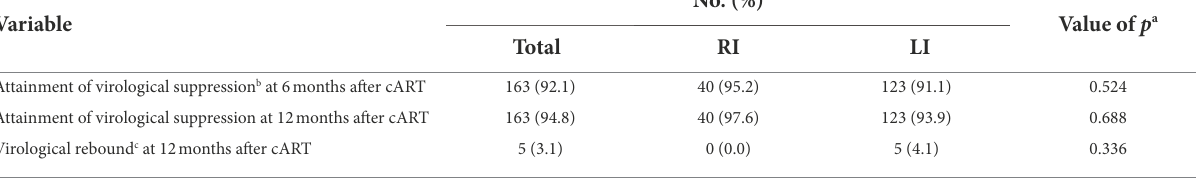
TABLE 4 Virological suppression and rebound in 200 cART-treated HIV-1 patients of recent or long-term infection.